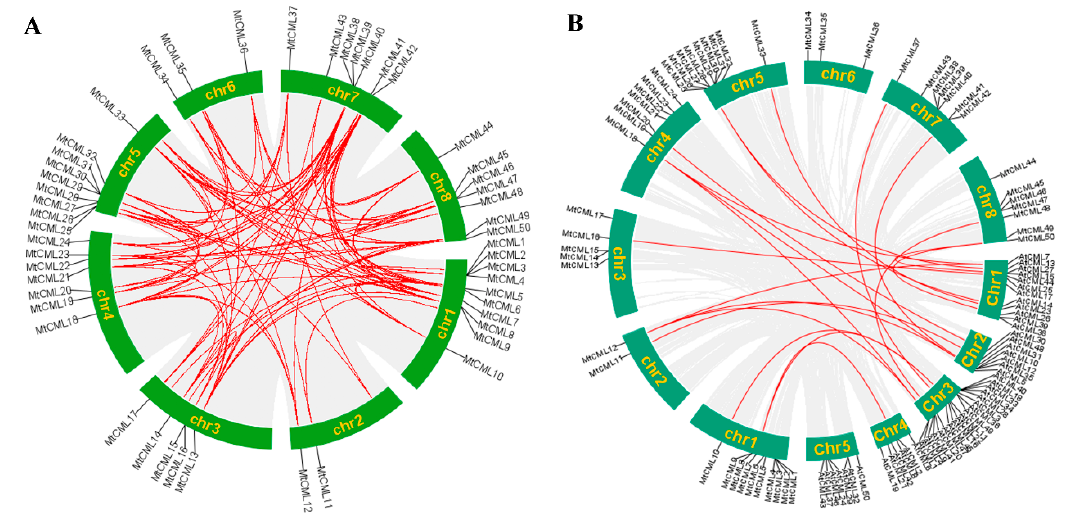
Figure 3. Chromosomal distribution and synteny analysis of CML genes in the genomes of Medicago truncatula and Arabidopsis thaliana . ( A ) Paralogous MtCML genes mapped onto M. truncatula chromosomes; ( B ) Orthologous CML genes mapped onto M. truncatula (chromosomes 1–8) and A. thaliana (chromosomes 1–5). Red lines indicate duplicated MtCML gene pairs.